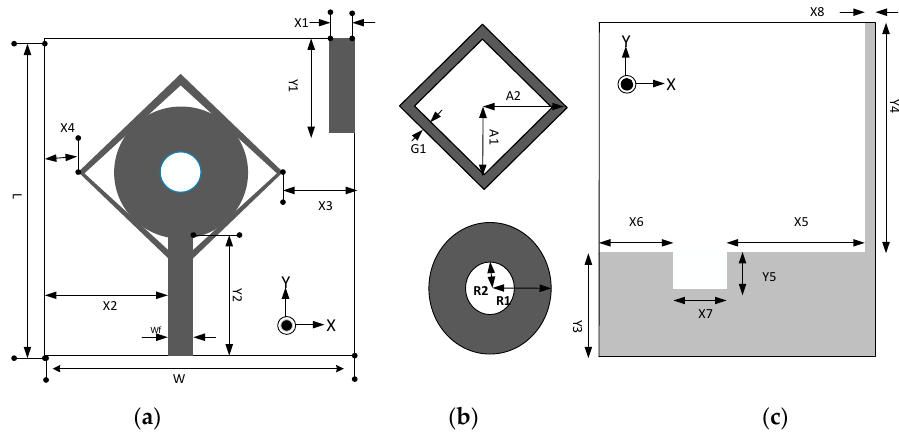
Figure 1. Geometry of the proposed single-element antenna. ( a ) Front view, ( b ) radiation patch elements, and ( c ) back view. Table 1. Proposed antenna dimension.